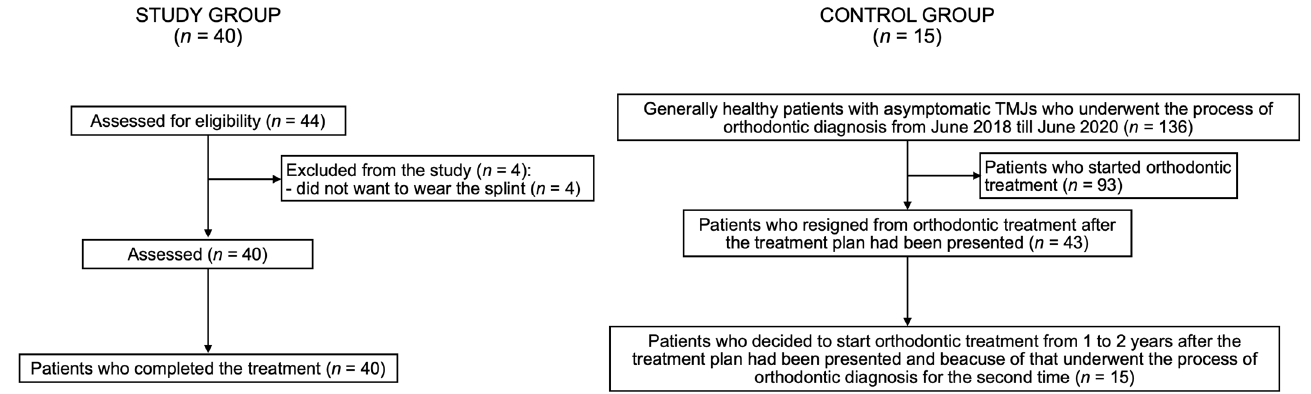
TMJ—temporomandibular joint;